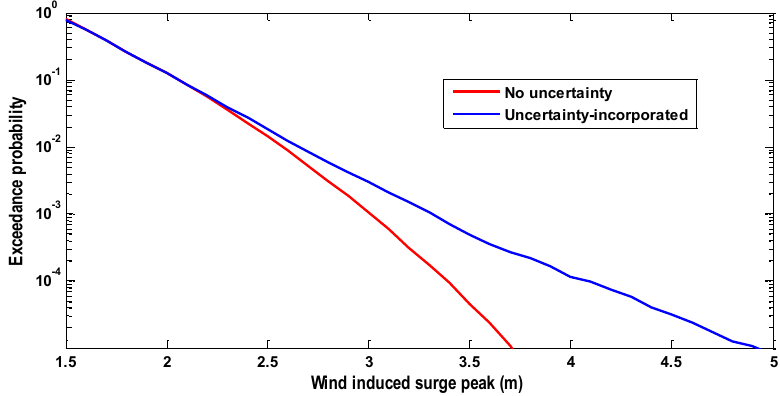
Figure 8. The uncertainty-incorporated marginal distribution of the wind induced surge h smax .